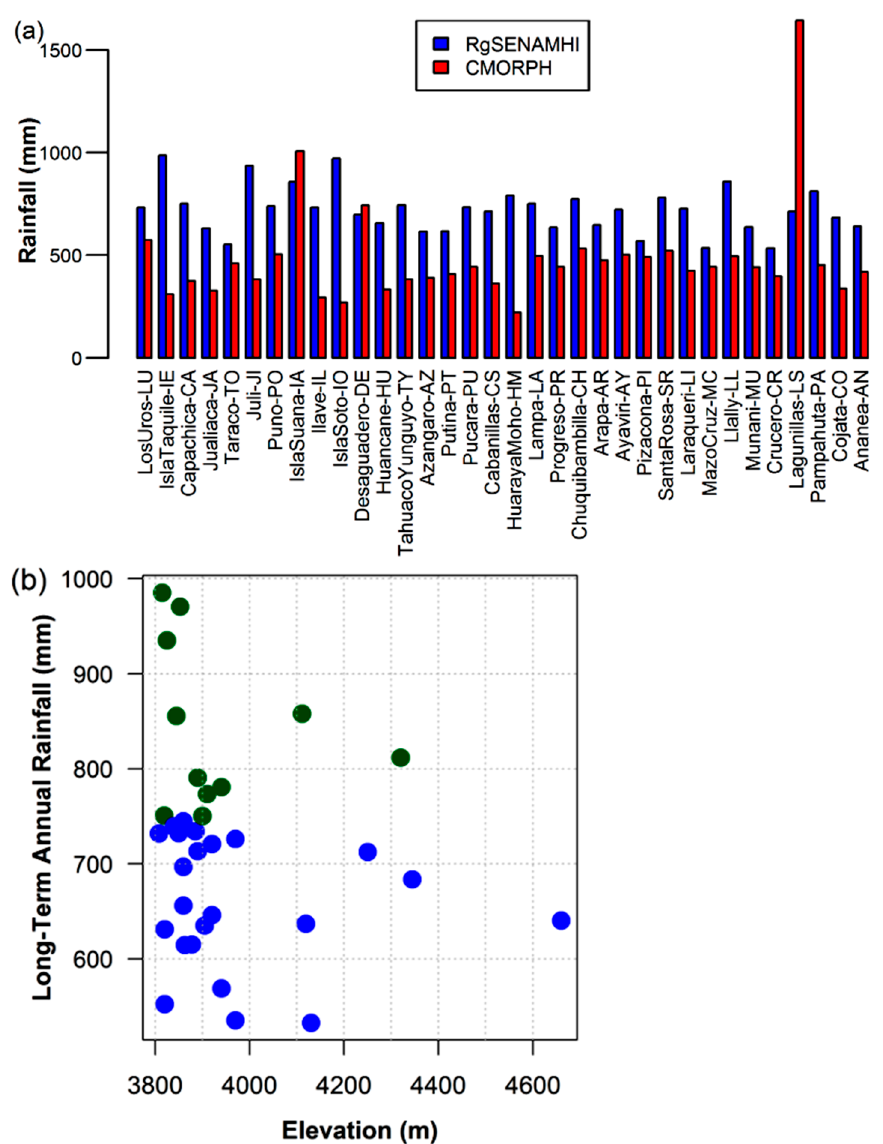
Figure 5. ( a ) Annual average rainfall CMORPH and RgSENAMHI (2002–2013) of selected stations in the Lake Titicaca basin. ( b ) Elevation vs. long-term annual average rainfall relations in the Lake Titicaca basin (34 stations from 2002 to 2013).